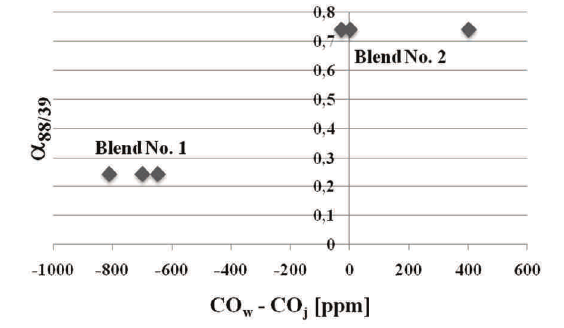
Fig. 3. The relationship between the reactivity coefficient a 88/39 determined for alternative fuels: Blend 1 and 2 in the MiniJetRig engine, and the difference (CO w – CO j ) measured at the engine speed of 39000, 70000 and 88000